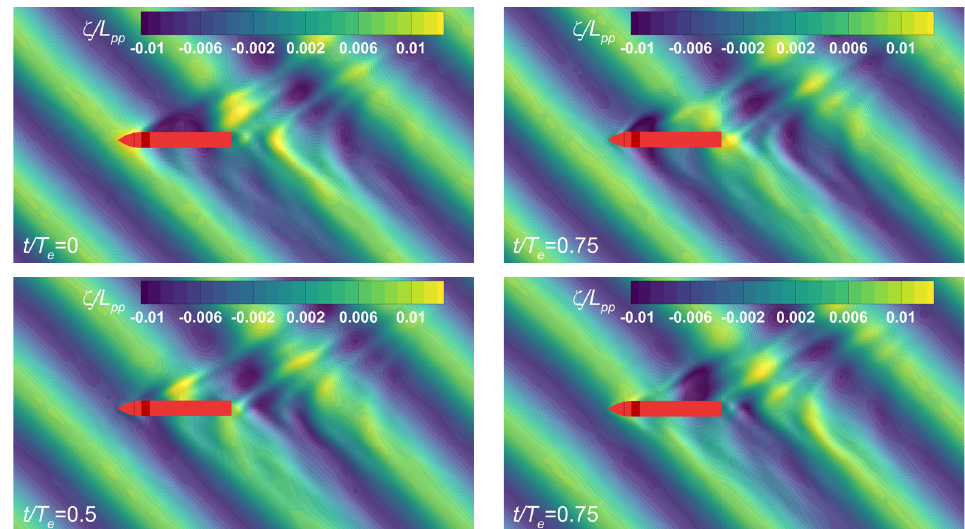
Figure 23. Free-surface elevations over a period of the quartering wave encounter. As a result of the interference, the resulting wave profiles on the ship hull lose their symmetry, as shown in Figure 24, which bears out the solution drawn at 𝑡 𝑇 (cid:3032) ⁄ = 0 . Defi- nitely, this change leads to non-symmetric pressure distribution on the hull and to its ef- fective wetted area, with consequences on the ship’s resistance and motions, as it will be shown in the following, when the added resistance in waves will be discussed. The wave profiles do not show any discontinuity, so no breaking is detected. The 𝑥 𝐿 (cid:3043)(cid:3043) ⁄ = 0 in Fig- ure 24 corresponds to the aft perpendicular, whereas 𝑥 𝐿 (cid:3043)(cid:3043) ⁄ = 1 corresponds to the fore perpendicular. It is worth mentioning that the wave cuts have the same elevation at the bow while notable differences are seen along the hull because of the relative angle be- tween the centerline of the moving hull and the direction of propagation of the main wave